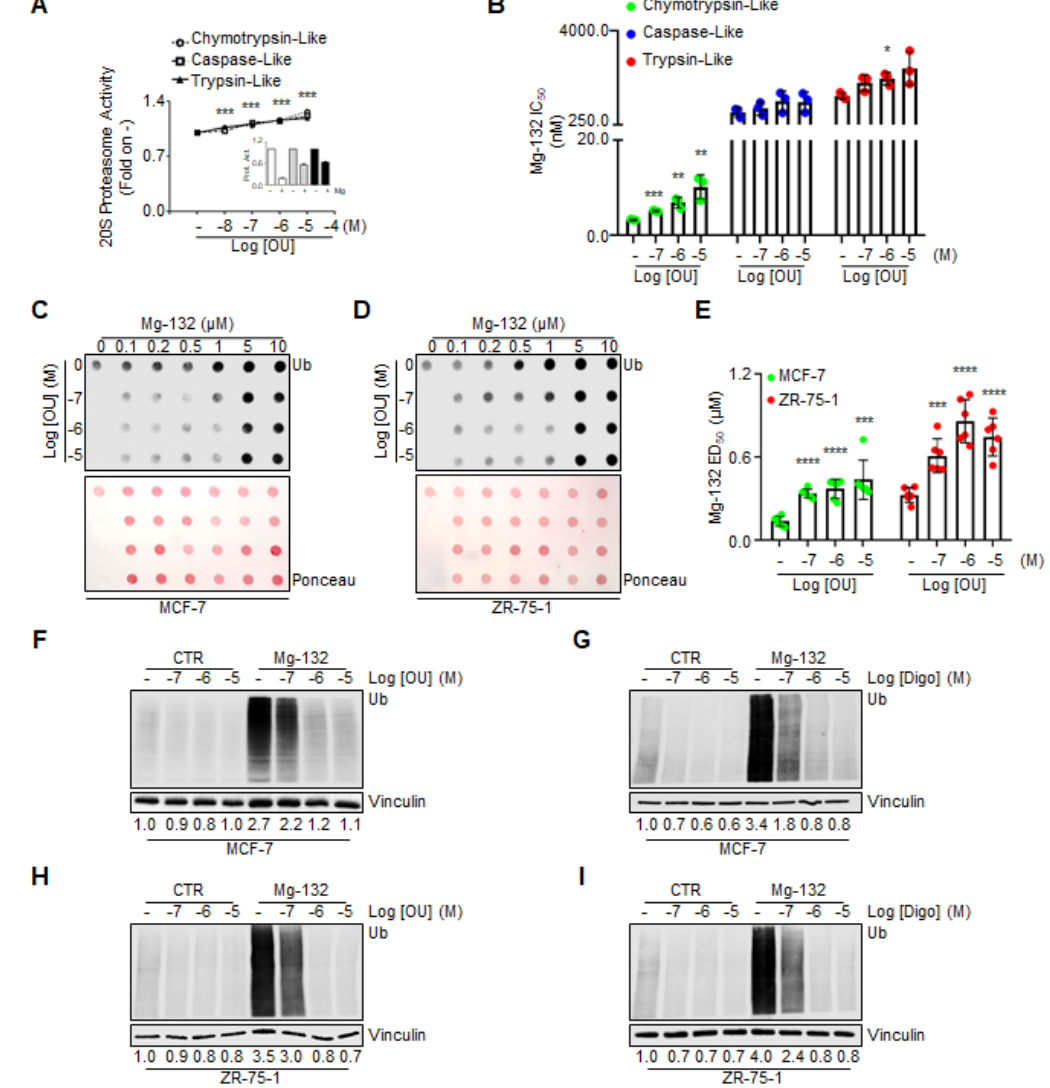
Figure 5. The effect of ouabain and digoxin on proteasome activity in vitro, and in cell lines. ( A ) In vitro evaluation of the proteasome activities (i.e., chymotrypsin-like, caspase-like, and trypsin-like), using recombinant commercially available 20S proteasome, and different doses of ouabain (OU). The inset in panel A indicates the effect of the proteasome inhibitor Mg-132 (1 µM) on all three proteasome activities (i.e., chymotrypsin-like, caspase-like, and trypsin-like). All experiments were performed